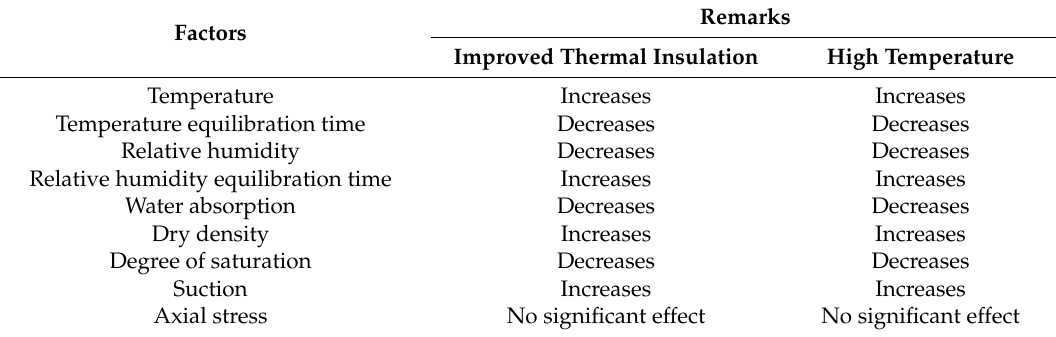
Table 4. Impact of improved thermal insulation and high temperature effects for non-isothermal loading on compacted